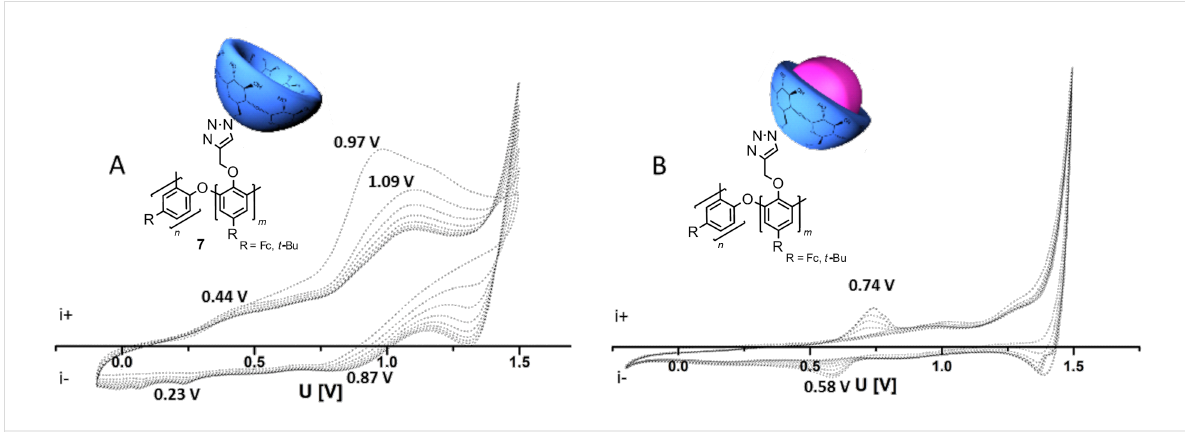
Figure 1: Cyclic voltammetry results of (A) clicked copolymer 7 , (B) clicked copolymer 7 with Ad-COOK ( ).